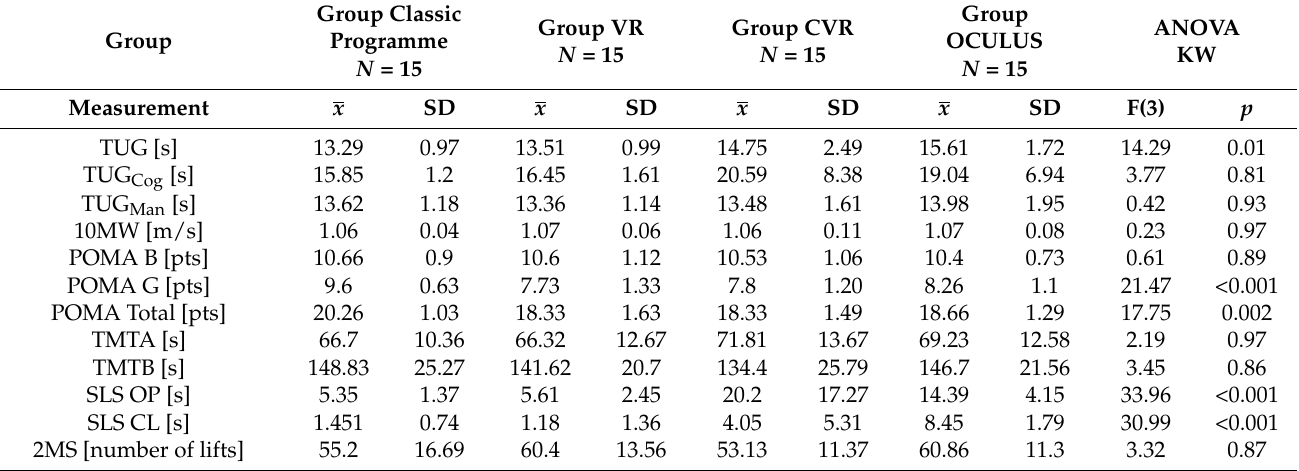
Table 2. Functional performance per respective study groups, as noted at the first measurement